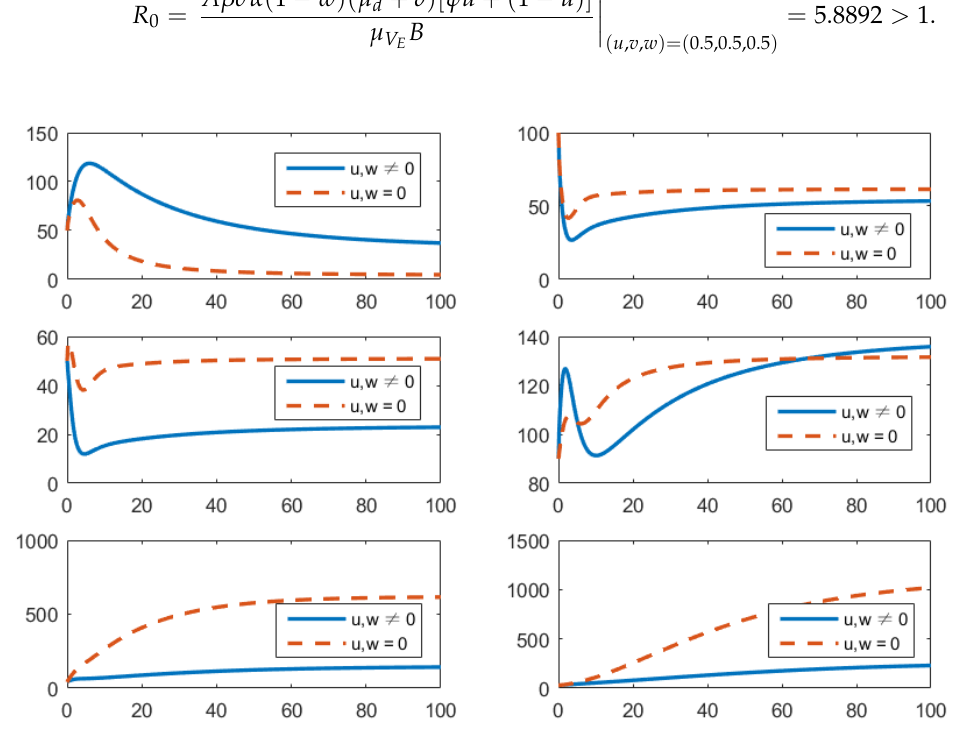
Figure 4. Comparison of adopting strategy A 3 versus not adopting. From left to right is S , E , I , R , V I , V E , respectively. The x -axis and y -axis, respectively, represent the time (days) and the corresponding population (persons).